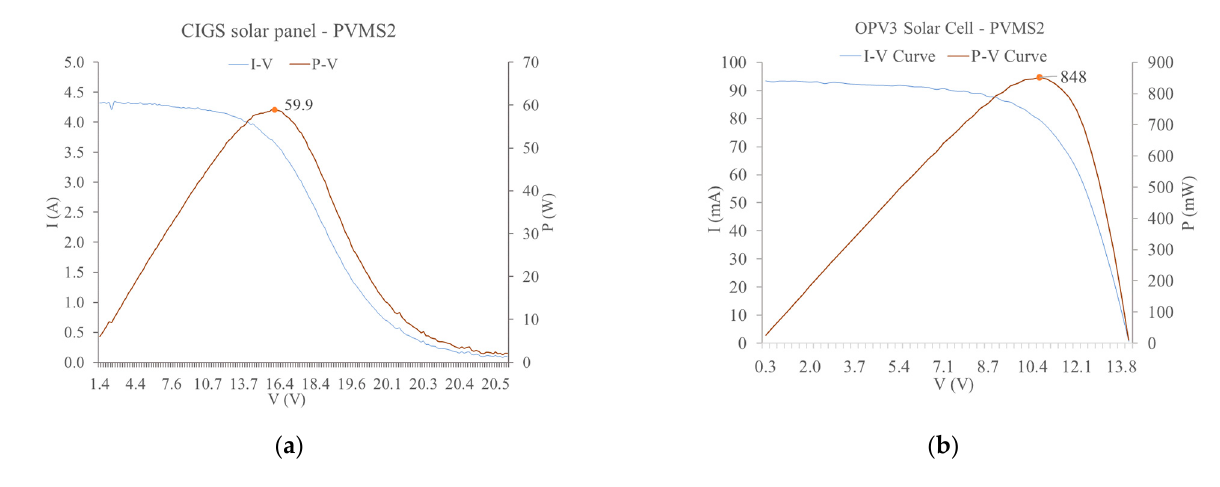
Figure 5. I-V and PV curves for ( a ) 70 w semi-flexible CIGS technology and ( b ) 1 W OPV3 mini- module. Table 3. Percent error calculated in the measurement of PV parameters with PVMS2 in reference to PROVA